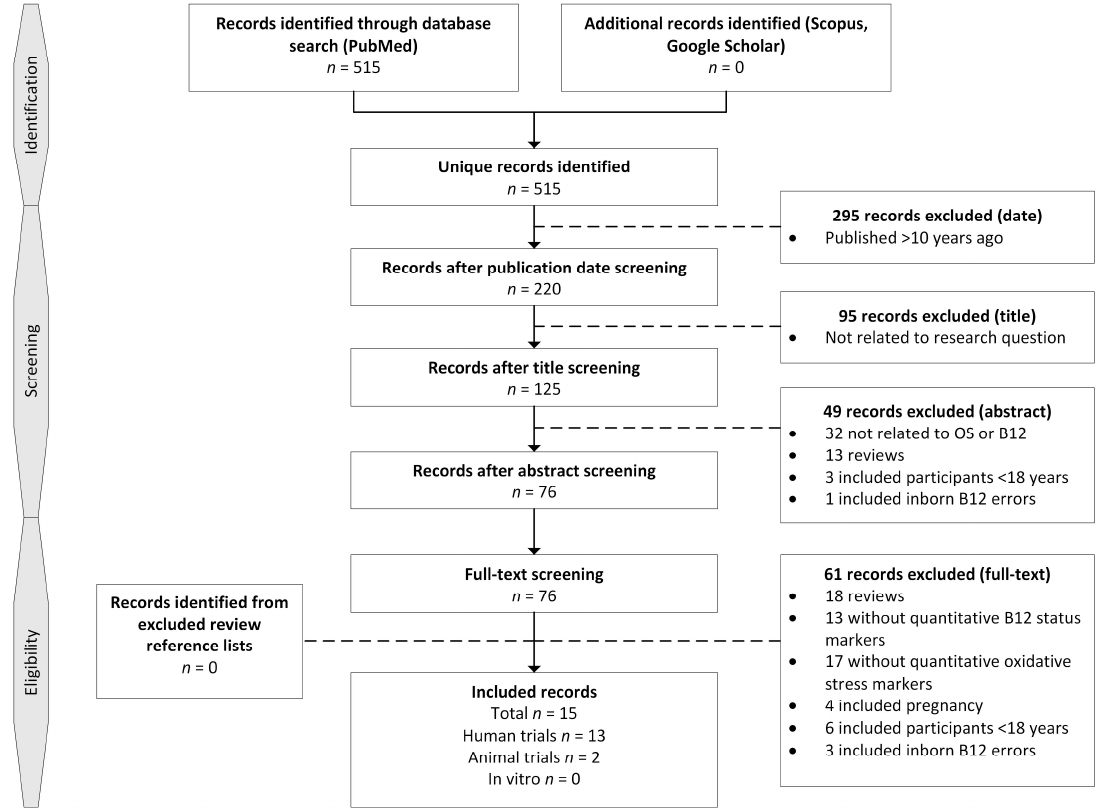
Figure 2. Study selection process